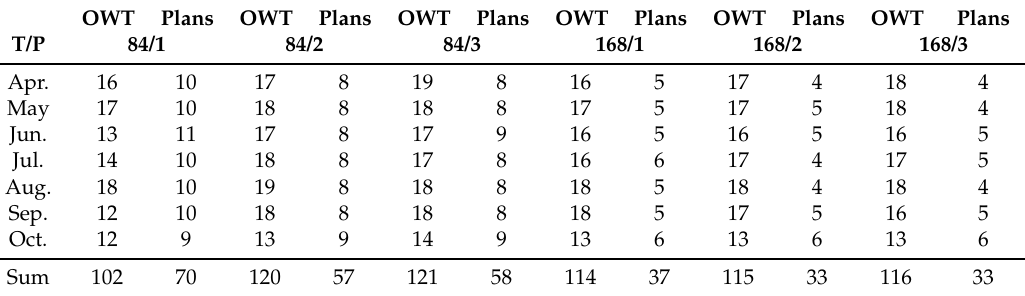
Table 6. MPC results for different T and